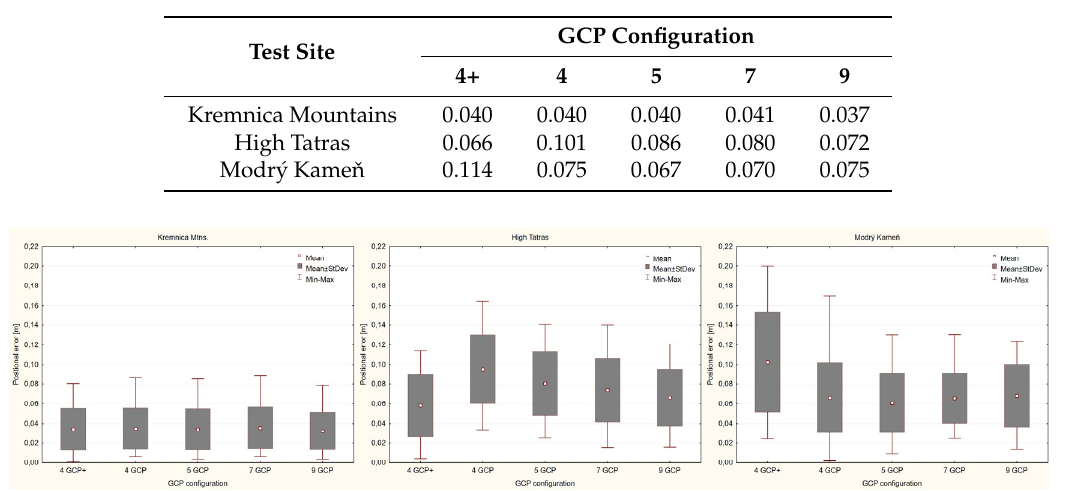
Figure 4. Minima, maxima, means and standard deviations of the positional errors Δ p according to the test sites and GCP